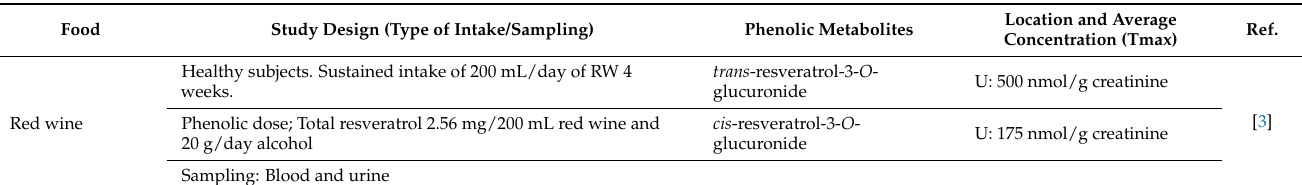
Table 6. Phenolic metabolites (phase I, phase II and colonic) proposed as intake biomarkers of red wine consumption in the Mediterranean